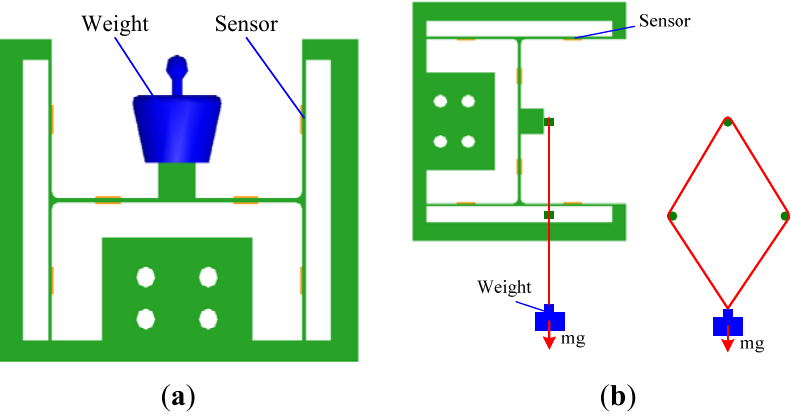
Figure 8. Loading programs for ( a ) the normal load and ( b ) the lateral load.